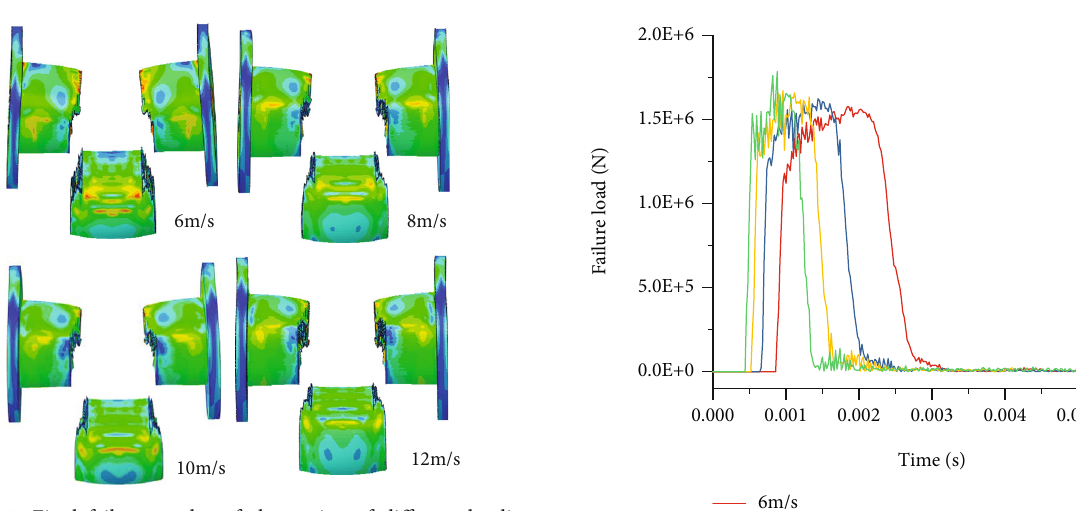
Figure 5: Final failure modes of shear pins of di ff erent loading rates.